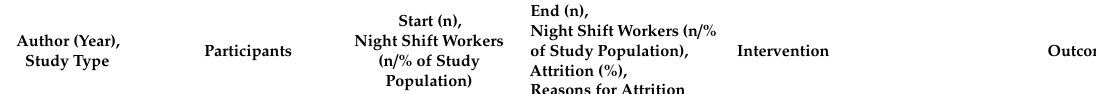
Compliance of Completers, Adverse